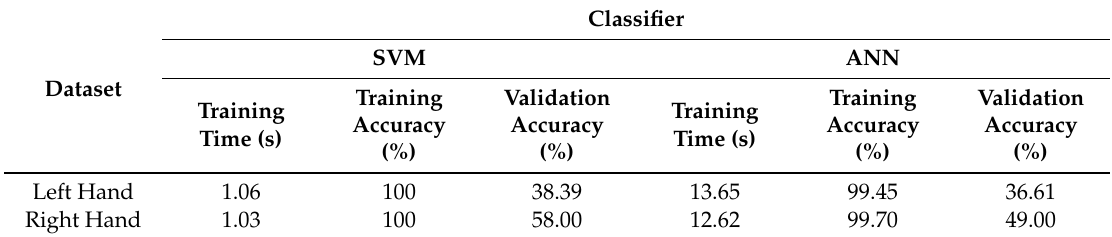
Table 4. Training and validation set accuracies for different datasets (user specific category).